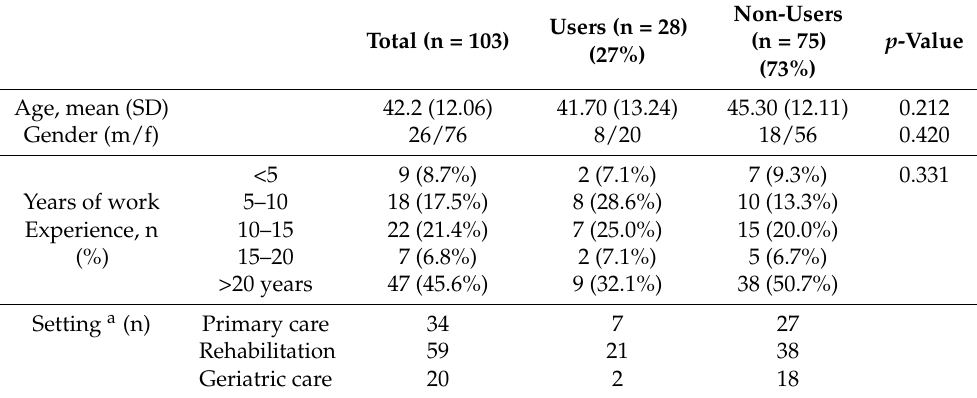
Table 1. Demographic characteristics of